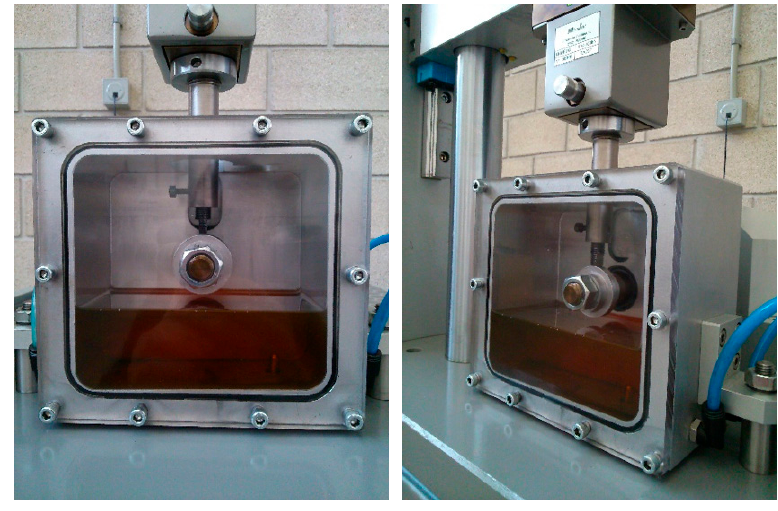
Figure 1. Equipment employed for testing the disks.